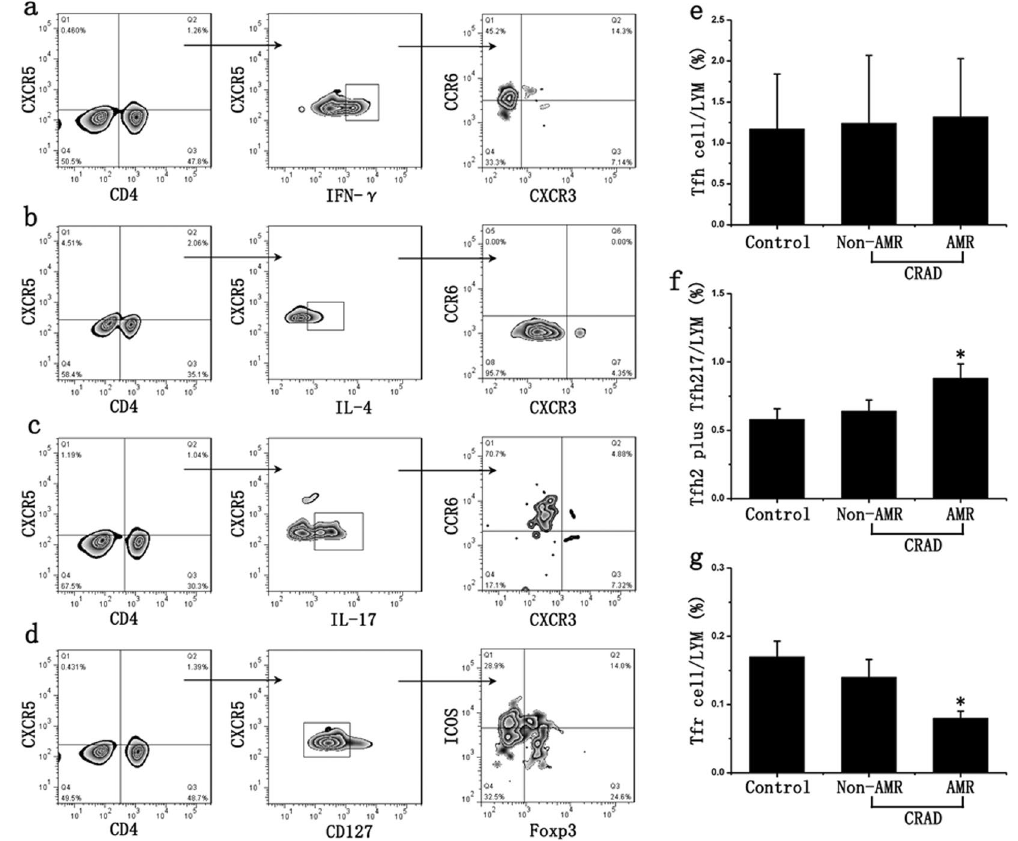
Figure 1. Changes of Tfh cell subsets in AMR. ( a ) CD4, CXCR5, IFN- γ , CXCR3 and CCR6 antibodies were used to detect Tfh1 cells; ( b ) CD4, CXCR5, IL-4, CXCR3 and CCR6 antibodies were used to detect Tfh2 cells; ( c ) CD4, CXCR5, IL-17, CXCR3 and CCR6 antibodies were used to detect Tfh17 cells; ( d ) CD4, CXCR5, ICOS, Foxp3 and CD127 antibodies were used to detect Tfh and Tfr cells; ( e ) CD4 + CXCR5 + ICOS + Tfh cell in lymphocyte (LYM) had no significant difference between AMR group and non-AMR group; ( f ) The ratio of IL-21-producing Tfh cells (CD4 + CXCR5 + IL-4 + CXCR3-CCR6-Tfh2 and CD4 + CXCR5 + IL-17 + CXCR3 − CCR6 + Tfh17 cell) in AMR group was significantly higher than that of non-AMR group; ( f ) The ratio of CD4 + CXCR5 + ICOS + FOXP3 + CD127 − Tfr cells in AMR group was significantly lower than that of non-AMR group. Two-sided Wilcoxon rank sum test: * p < 0.05 (n = 40) versus non-AMR. Values are mean ±